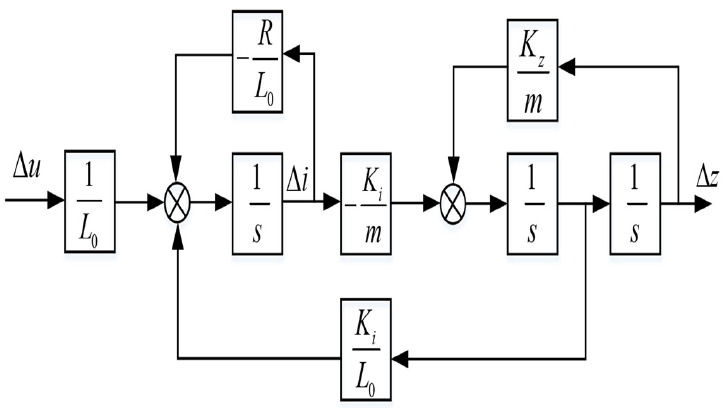
Figure 4. Linear open loop model block diagram of suspension system.